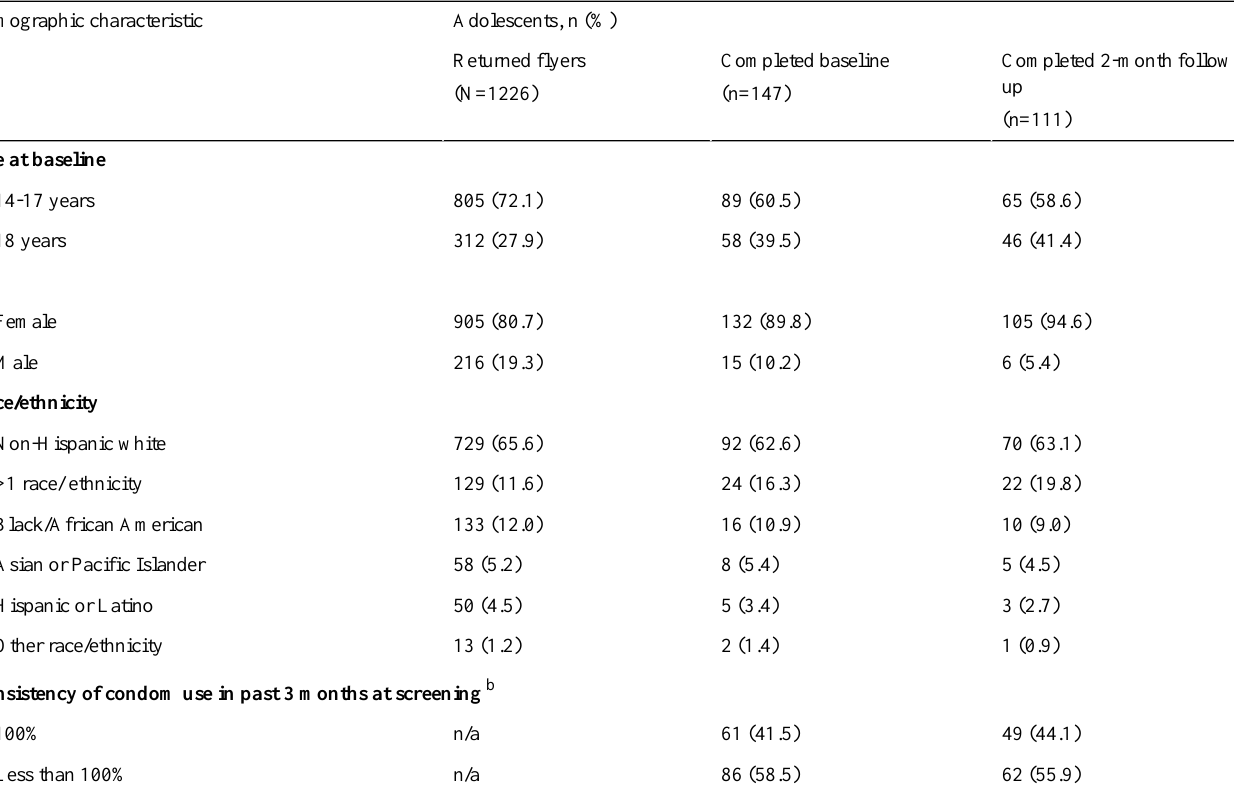
Table 1. Demographic characteristics of adolescents who returned flyers, completed the baseline survey, and completed the 2-month follow-up survey (N=1226).